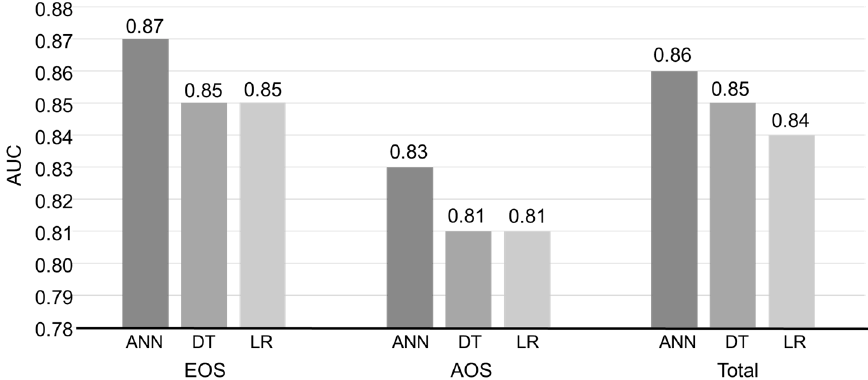
Figure 2. Neurological soft sign (NSS) prediction accuracy estimated via training full data and 10-fold cross-validation for early-onset (EOS) and adult-onset schizophrenia (AOS), and all patients with schizophrenia (Total). ANN, artificial neural networks; DT, decision trees; LR, logistic regression.